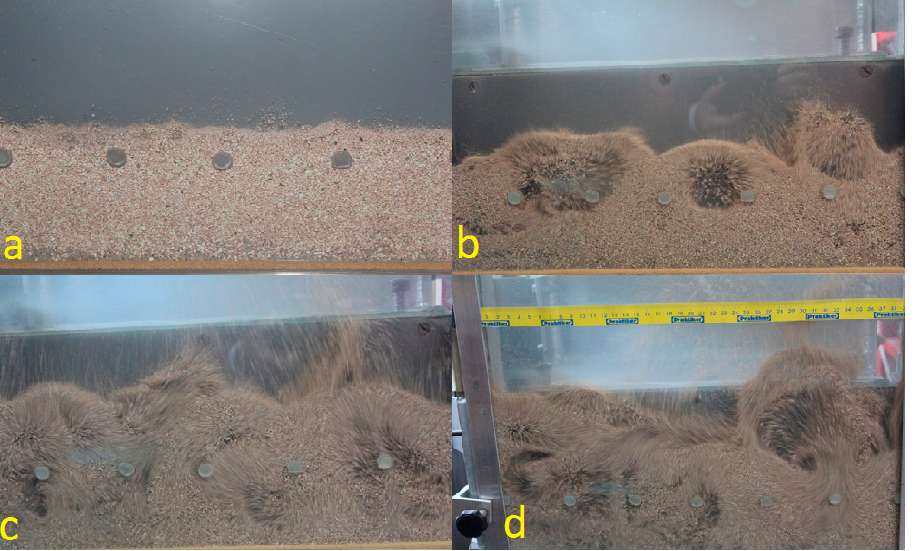
Figure 4. Development of a fluidized layer made of calcined material with increasing fluidization velocity: ( a ) filtration, fluidization velocity Uf < 0.4 m/s, ( b ) start of bubble fluidization, Uf = 0.4 m/s, ( c ) fluidization bubble fluidization, 0.4 < Uf < 0.9 m/s, ( d ) developed bubble fluidization, Uf > 0.9 m/s.